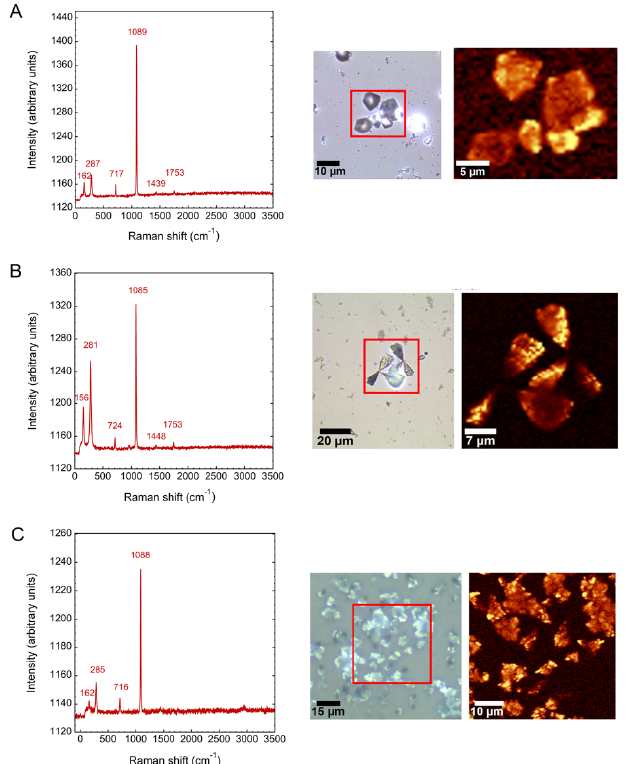
Figure 4. Raman spectroscopic analysis of calcite silica carbonate biomorphs obtained in different conditions. ( A ) Control in the absence of enzyme. ( B ) Suberitis domuncula silicatein- α . ( C ) Tethya aurantia silicatein- α . Left panels correspond to the Raman spectra. Right panels correspond to the optical image and mapping at the most intense Raman signal.